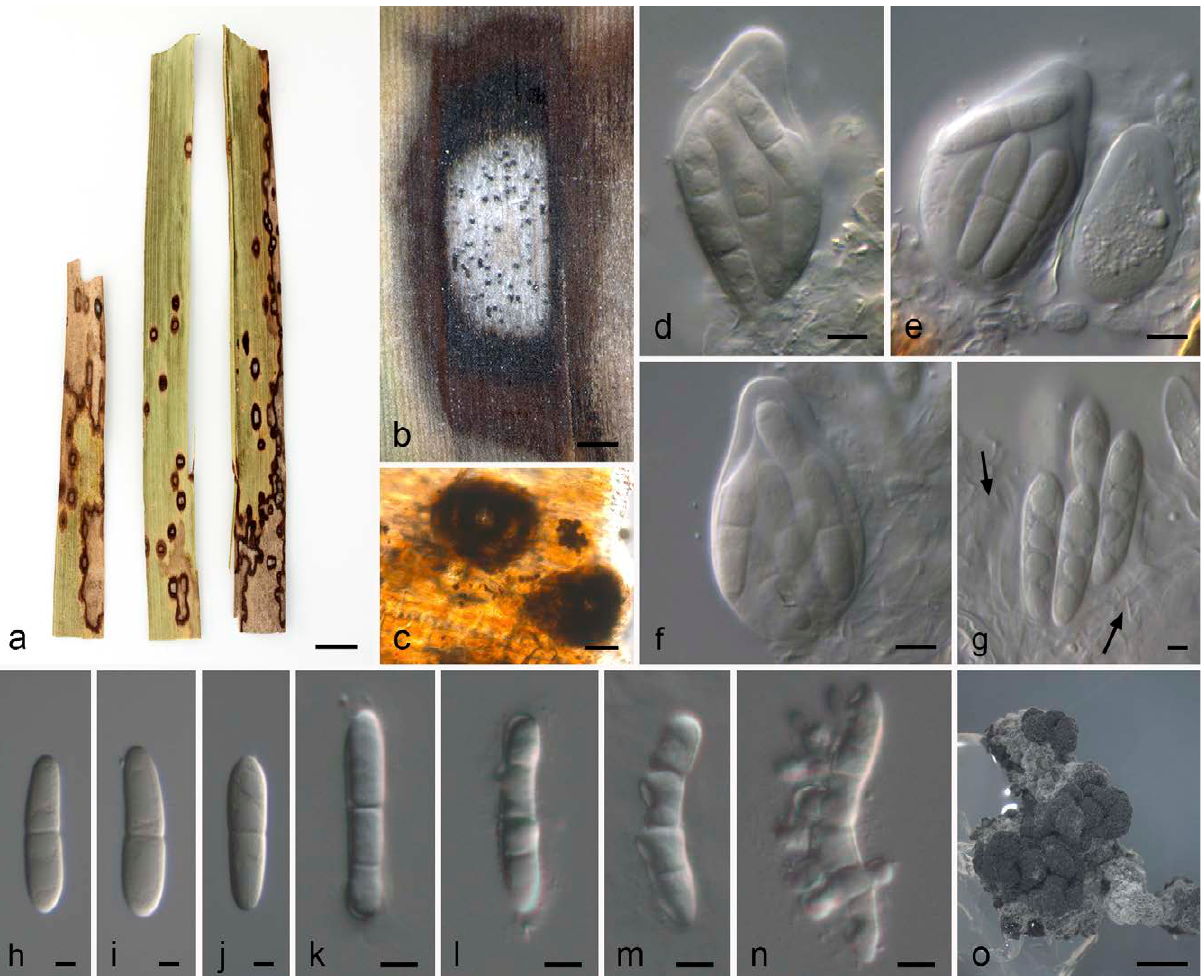
Figure 1. Palmeiromyces chamaeropicola (CDP 001, ex-type). a, Leaf spots on segments of Chamaerops humilis . b and c, Appearance of ascomata on host leaf surface. d, e and f, Asci and cellular hamathecium remnants. g, Immature ascospores (black arrows indicate remnants of cellular hamathecium). h, i and j, Mature ascospores. k, l, m and n, Germinating ascospores (k, after ca. 6 h incubation; l, after ca. 12 h incubation; m, after ca. 24 h incubation; n, after ca. 48 h incubation). o. Three-month-old colony on 1/2 PDA. Scale bars: a = 10 mm, b